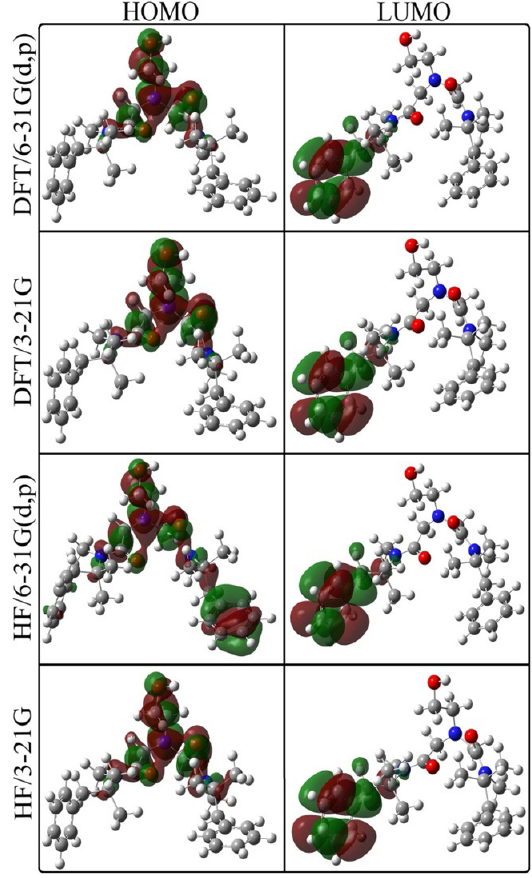
Figure 9. HOMO and LUMO populations of 2,2’-(2-Hydroxyethylimino) bis[N-(alphaalpha-dimethylphenethyl)-N-methylacetamide] obtained at different